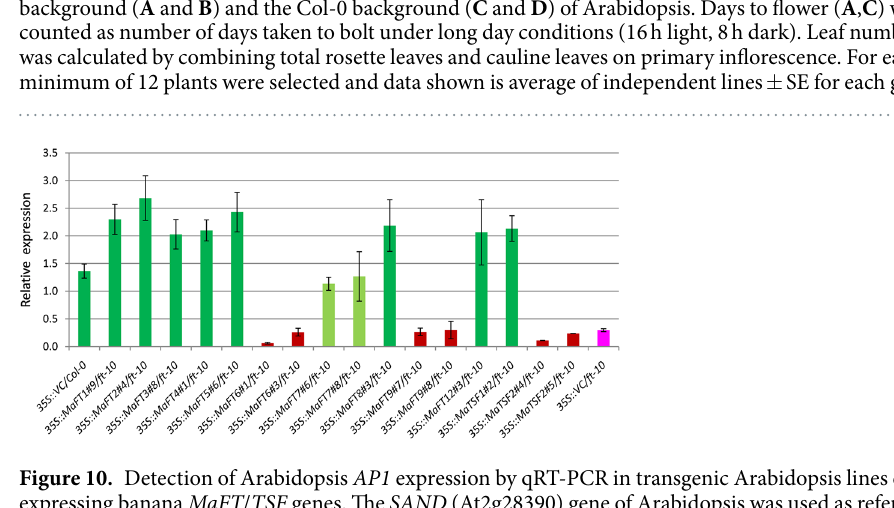
9 Scientific RePoRtS | 7: 5935 | DOI:10.1038/s41598-017-06118-x